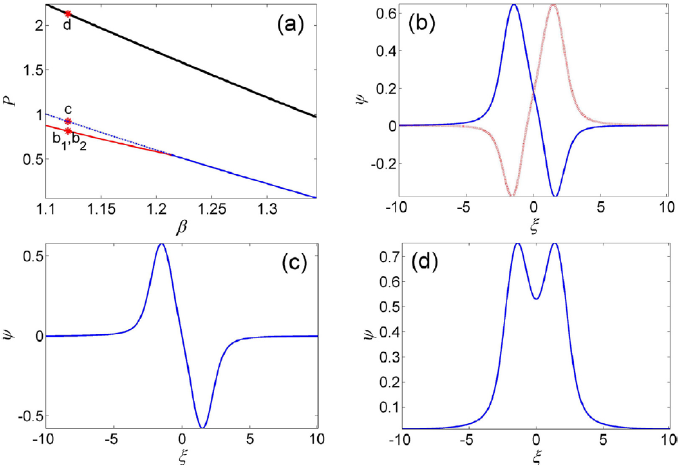
Figure 7. ( a ) Blue, red, and black lines show, respectively, the norm (power, here denoted P ) of antisymmetric, asymmetric, and symmetric solitons vs. their propagations constants (denoted β ≡ − µ here) in the fractional system based on Equation (1) with the double-well potential (34) and g = − 1 (the self-defocusing nonlinearity). Other parameters are the same as in Figure 6. The solid and dotted segments of the blue line represent, respectively, stable and unstable subfamilies of antisymmetric solitons below and above the symmetry-breaking bifurcation. The branches of antisymmetric and asymmetric solitons are completely stable. Panels ( b – d ) display a pair of stable asymmetric solitons (mirror images of each other), an unstable antisymmetric soliton, and a stable symmetric one, all taken at β = 1.12 (these solitons correspond to dots b 1,2 , c, and d in panel ( a )). Reprinted with permission from Reference [42]. Copyright 2020